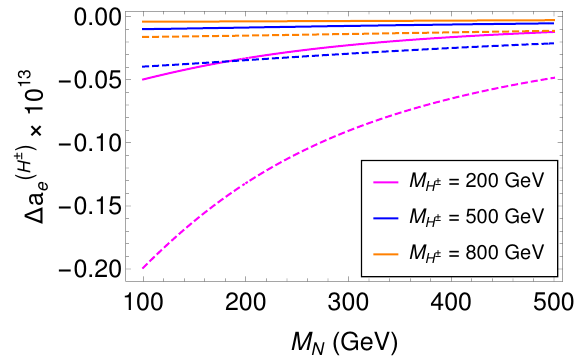
Figure 14 . One loop charged Higgs contribution to lepton anomalous magnetic moment and τ → eγ .